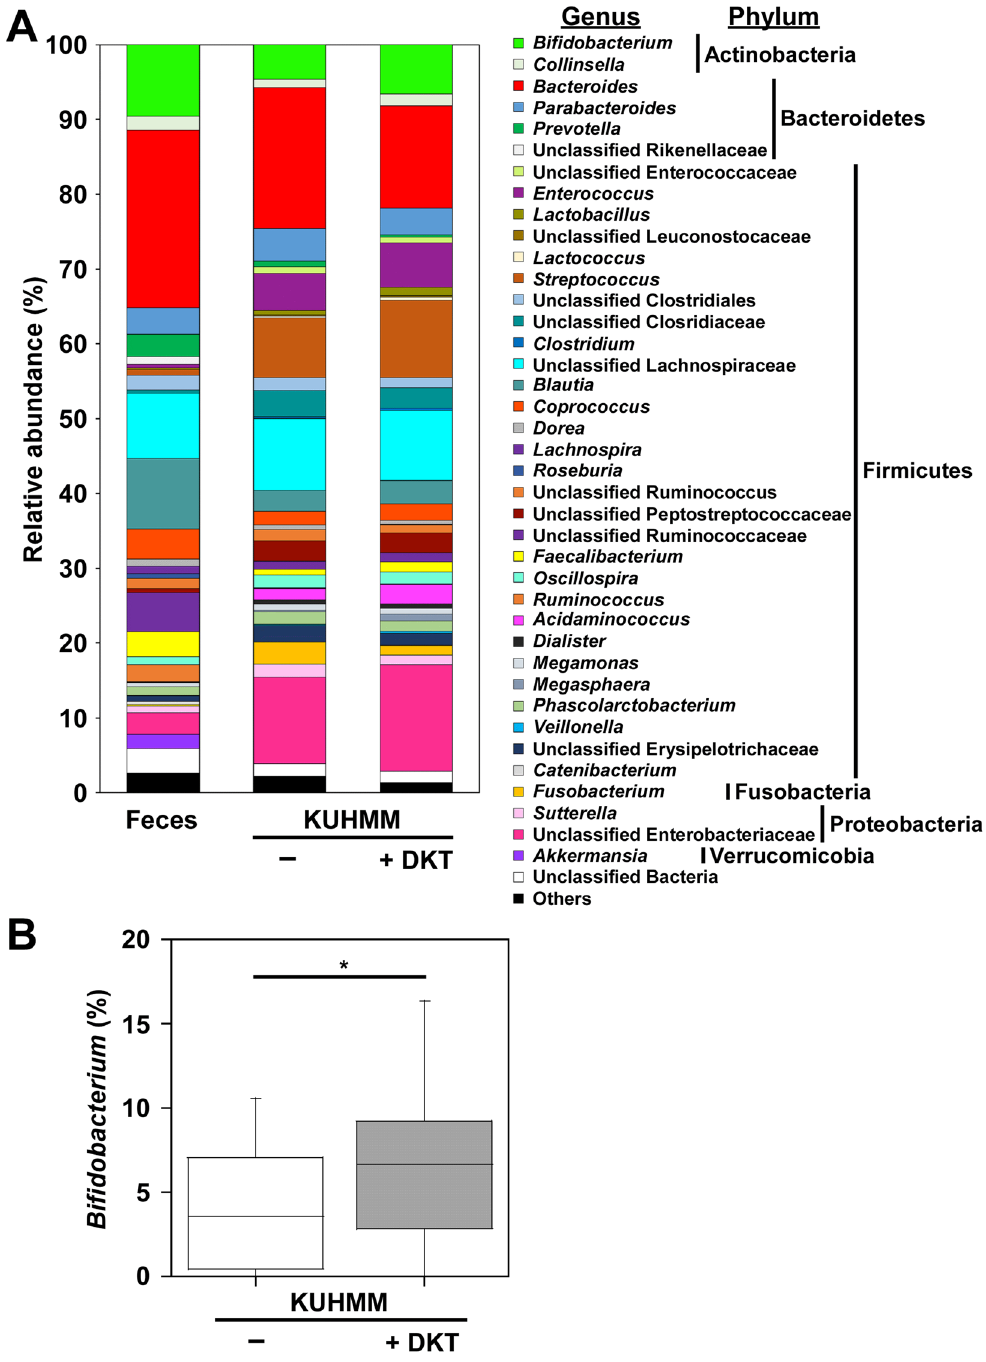
Figure 2. Effect of the daikenchuto (DKT) on bacterial taxonomic composition. ( A ) Genus-level classification of bacteria in original fecal inoculums (Feces) and in vitro human colonic microbiota model (KUHIMM) without (−) and with DKT (+ DKT) after 48 h of fermentation. Genera of lower abundance (< 1.0%) and lower similarity (< 97%) were included as Others and Unclassified Bacteria, respectively. Means are shown for nine healthy human subjects. ( B ) Relative abundances of bacteria related to genus Bifidobacterium . * P <